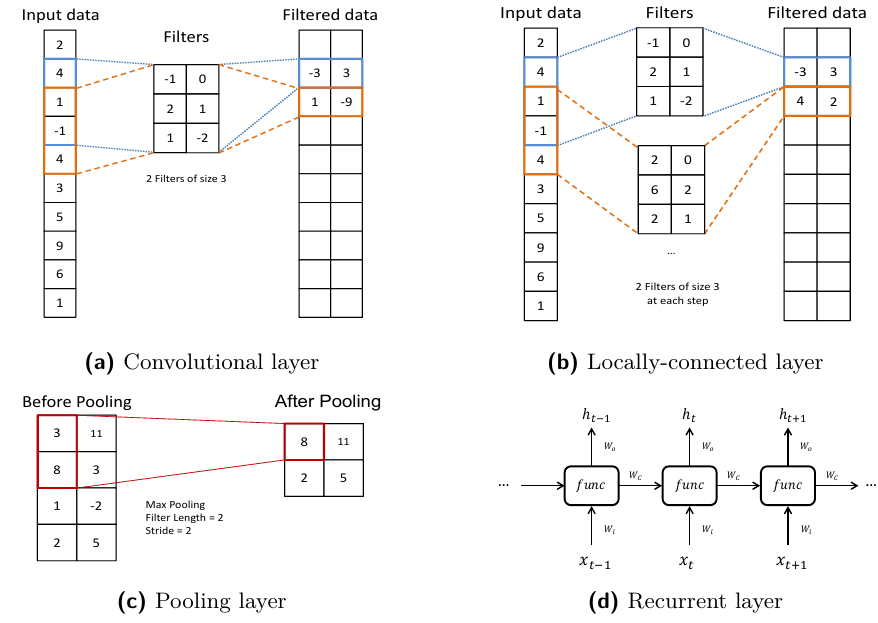
Figure 1: Examples of neural network